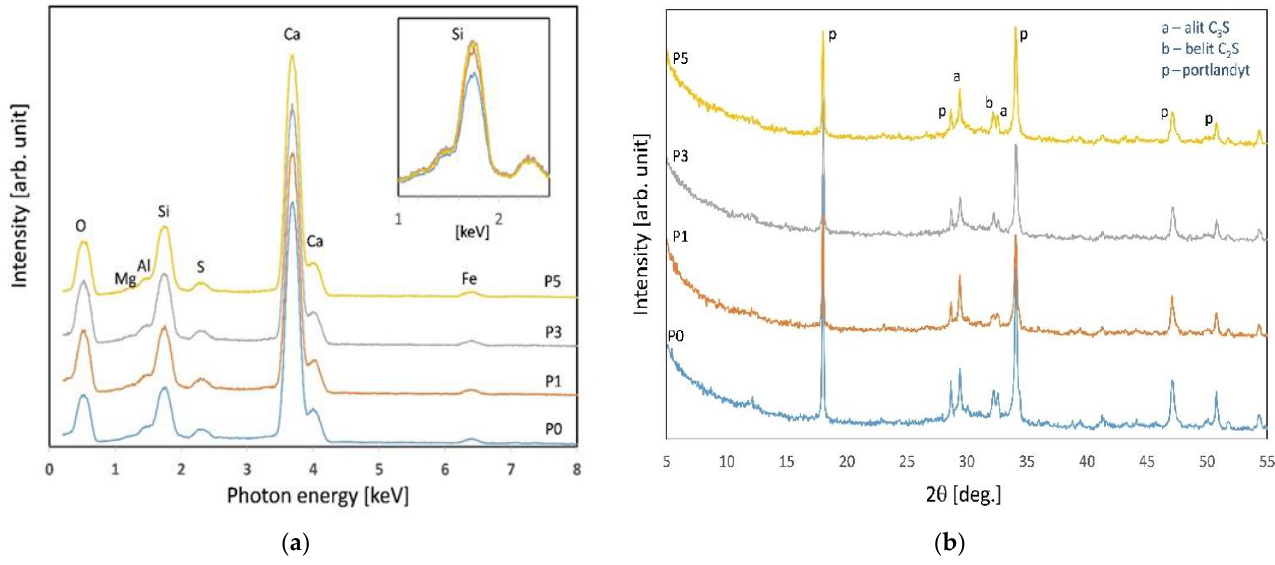
Figure 4. EDS spectra ( a ) and XRD spectra ( b ) of specimens after 28 days of curing. All the samples exhibit similar phase composition to reference sample P0. The dif- ference between the samples is the amount of amorphous phase SiO 2 . The amorphous phase is not visible on the diffractograms but affects the absolute intensity of